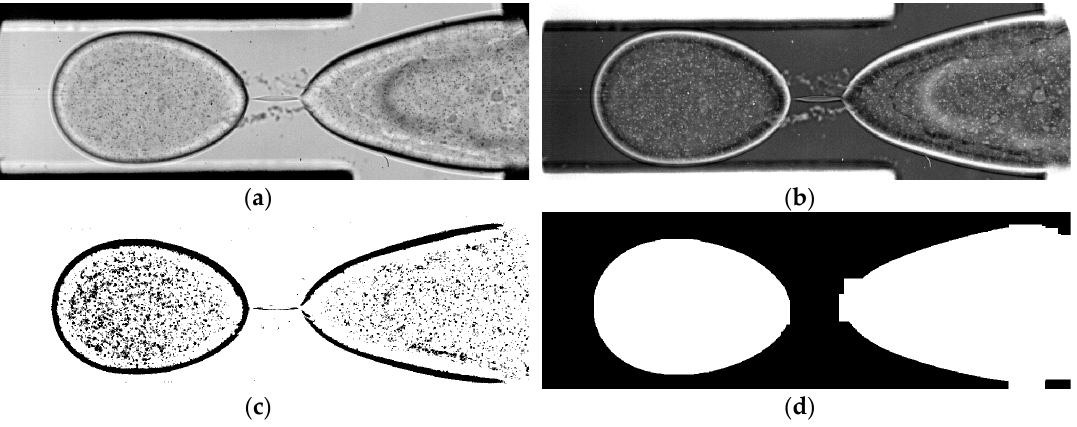
Figure 6. Steps of image pre-processing and dynamic masking: ( a ) Raw image at rupture instance, ( b ) pixel value inversion, ( c ) harmonic mean subtraction and thresholding (inverted), ( d ) dynamic mask. Channel width is 250 µm.